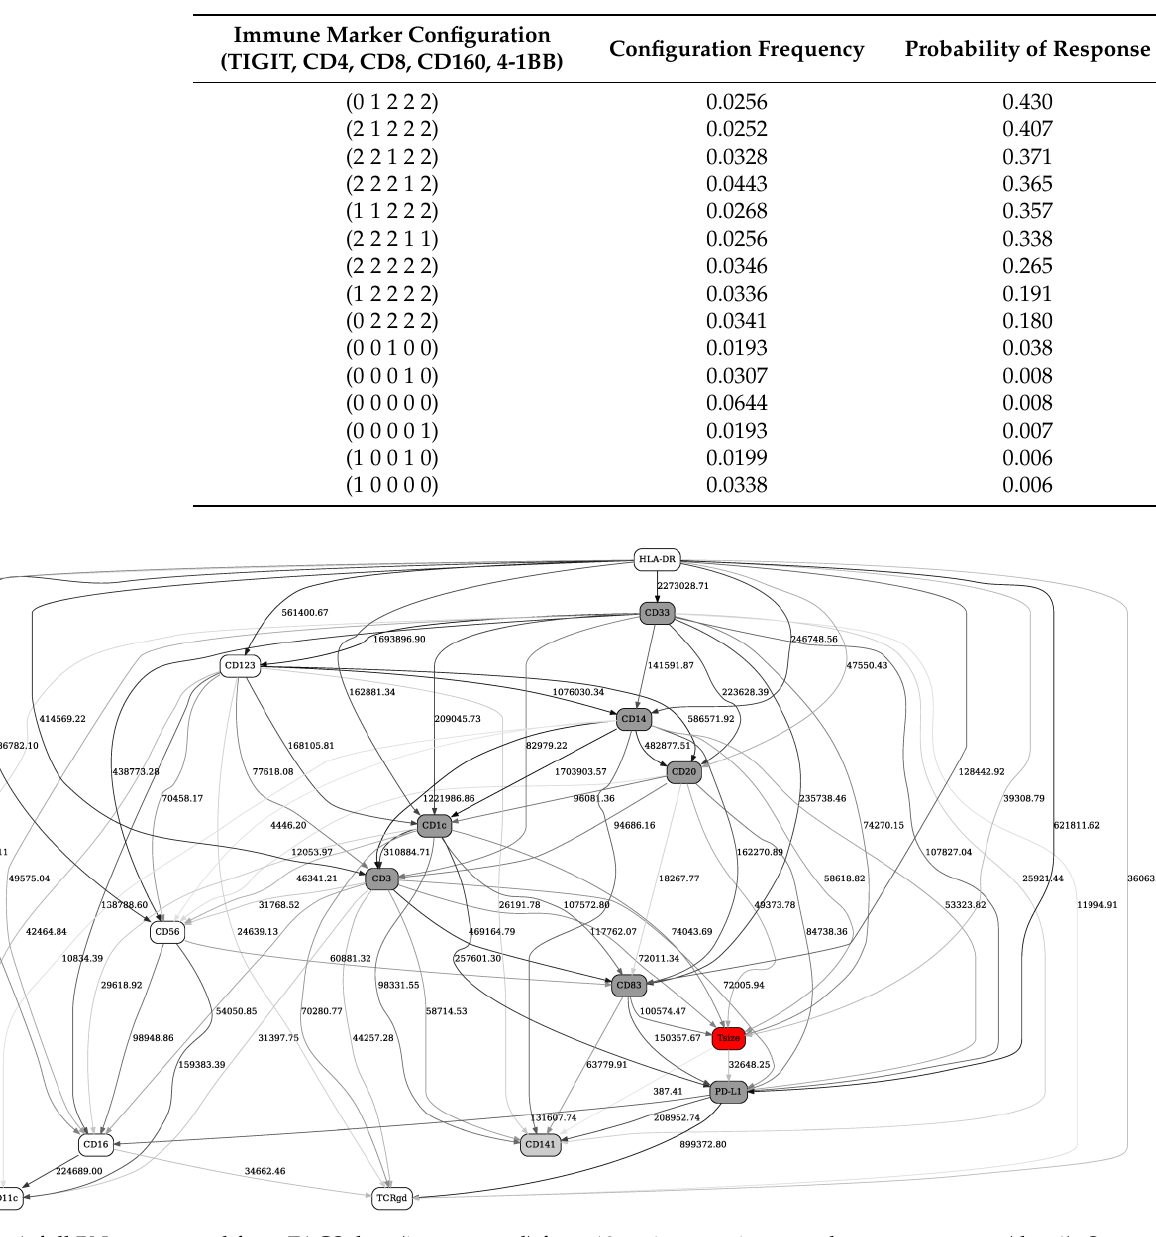
Figure 2. A full BN constructed from FACS data (innate panel) from 13 patients preimmunotherapy treatment (day 1). See Figure 1 legend for further details.